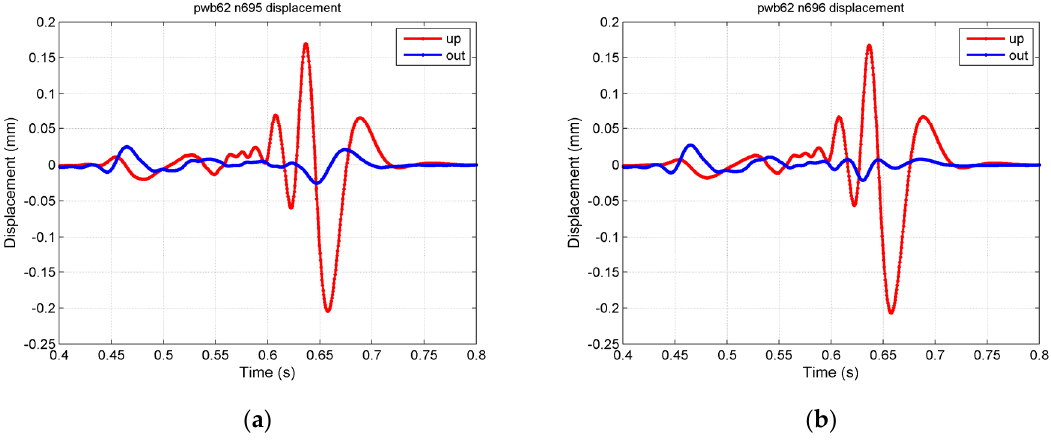
Figure 8. ( a ) Node 695 is at 0.25 m depth; ( b ) Node 696 is at 0.5 m depth.